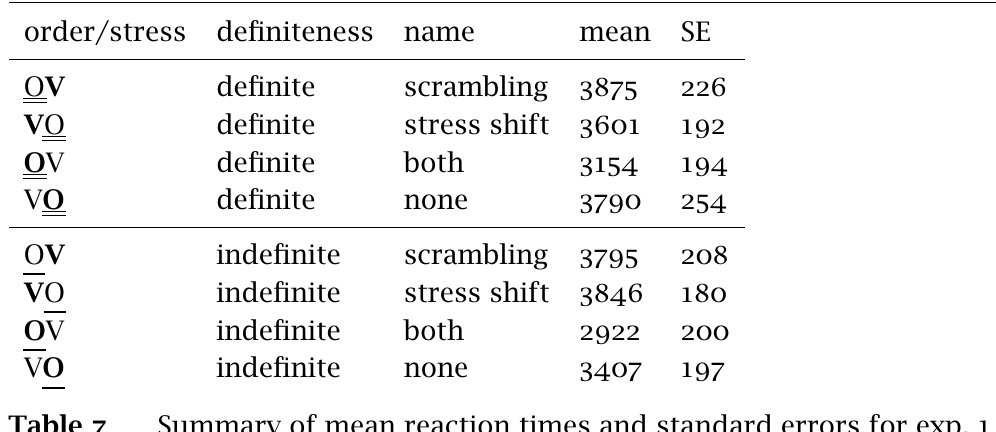
Summary of mean reaction times and standard errors for exp.